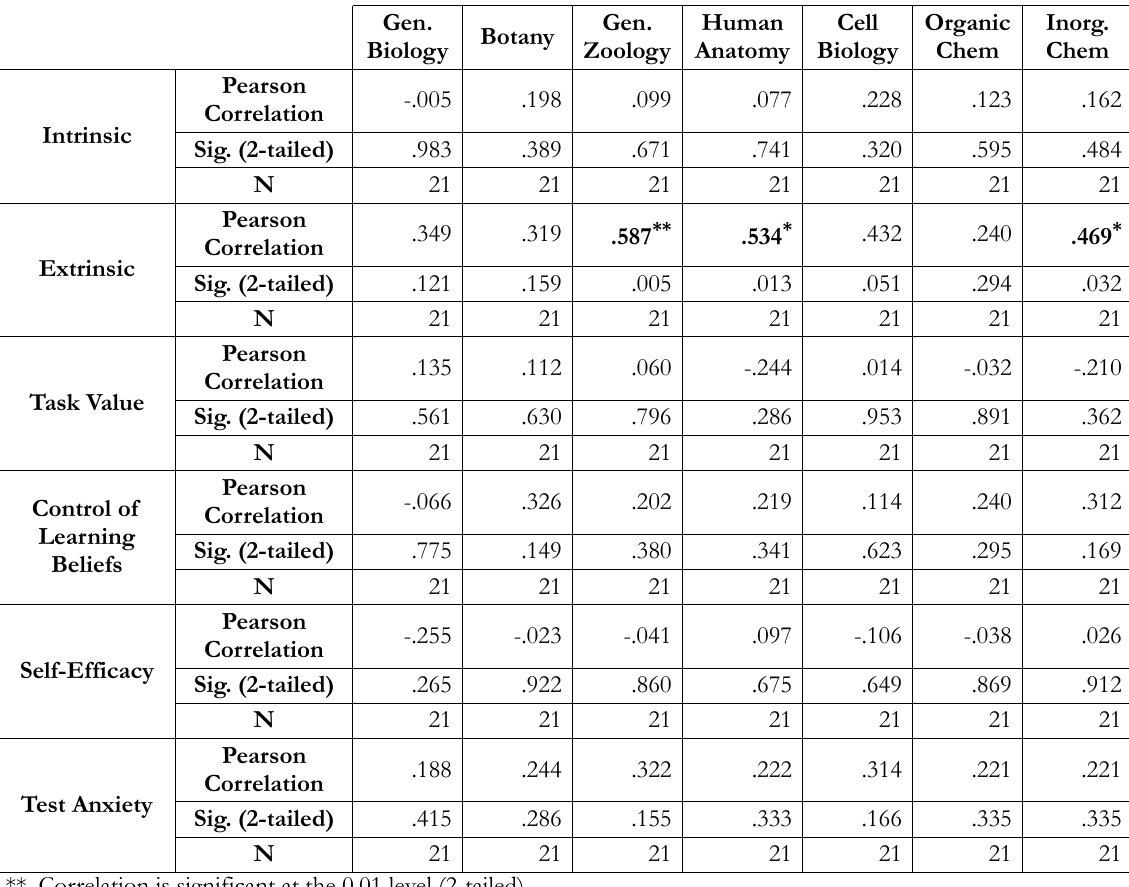
Table 5. Respondents’ Motivation in Learning and their Academic Performances in Science